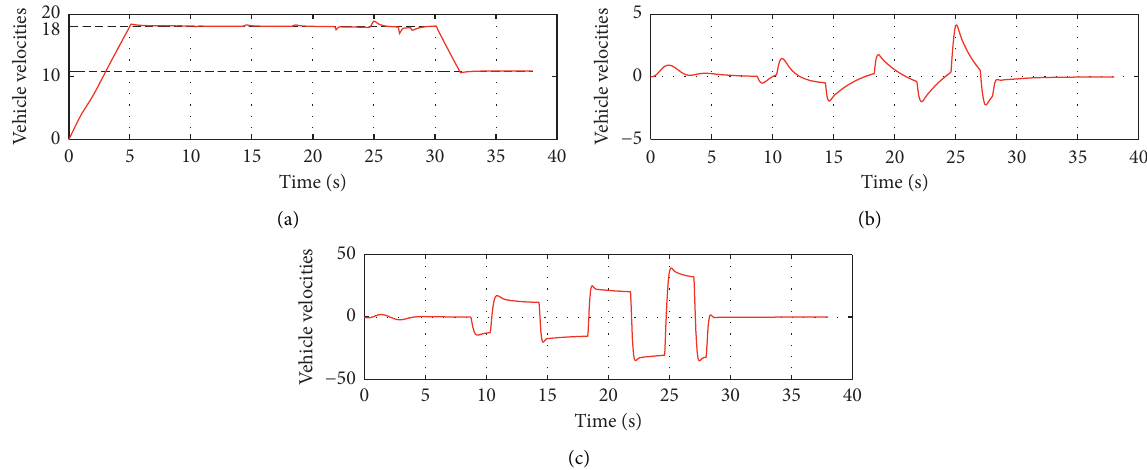
Figure 7: Time histories for longitudinal and lateral velocities and yaw rate of the path-following vehicle. (a) Longitudinal velocity (km/h). (b) Lateral velocity (km/h). (c) Yaw velocity